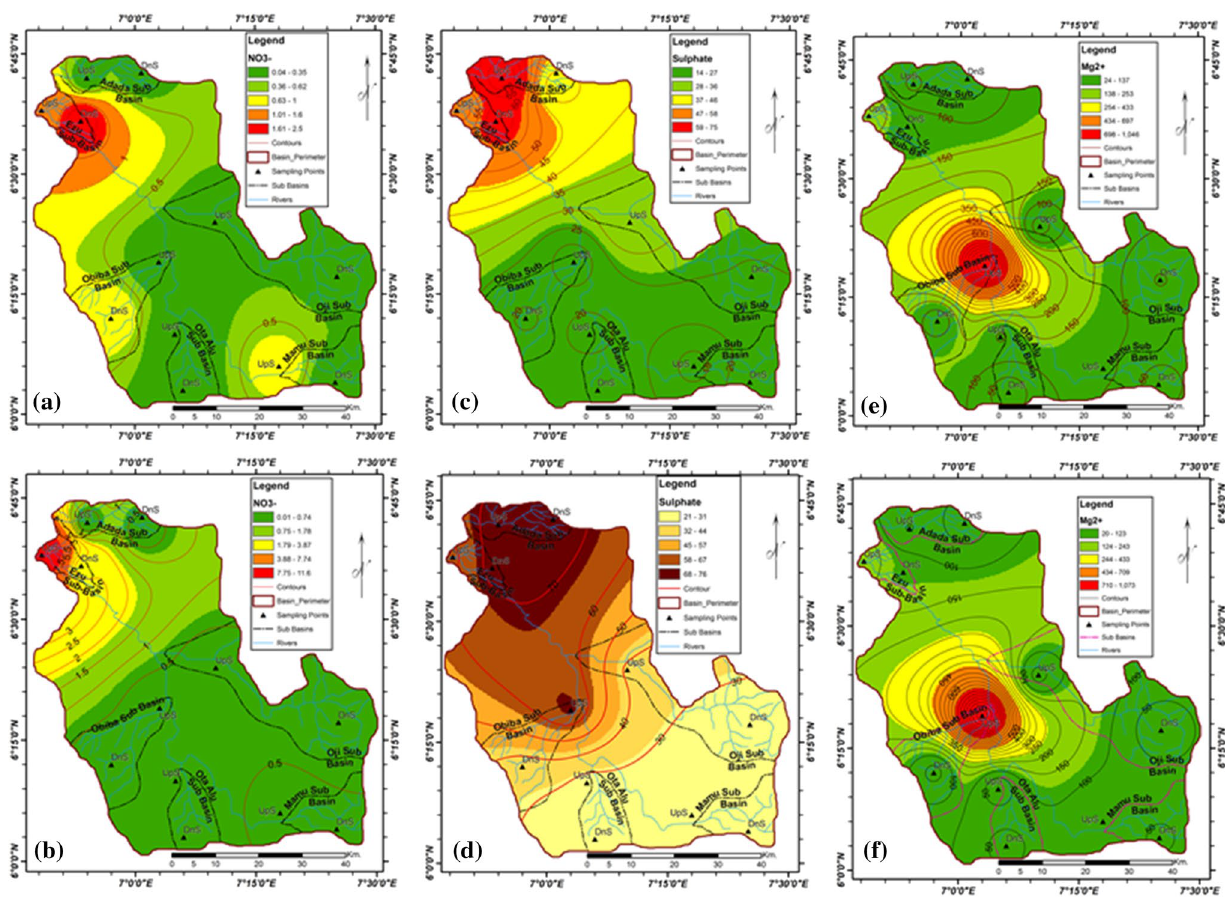
Fig. 12 Spatial distribution of nitrate, sulfate and